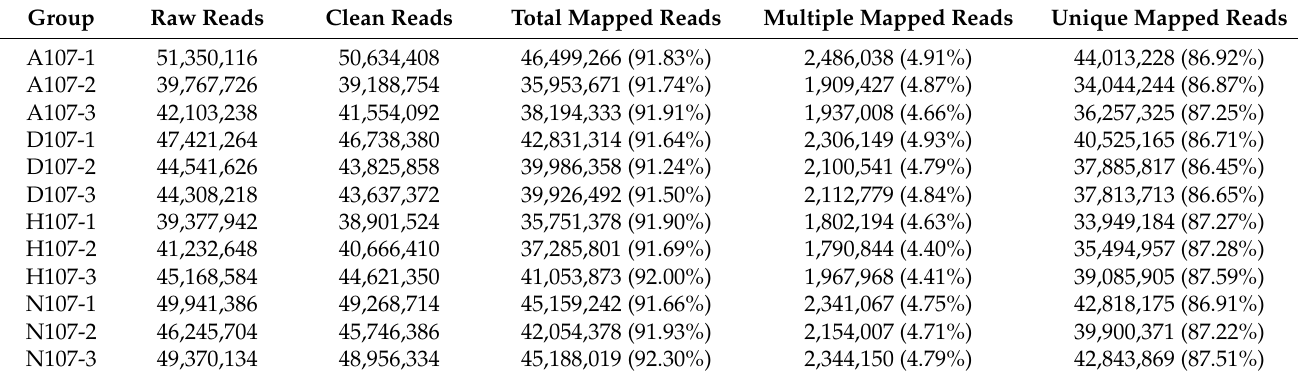
Table 1. The raw, clean, total mapped, unique mapped, and multiple mapped reads obtained by RNA-seq analysis of L. crocea in different groups.